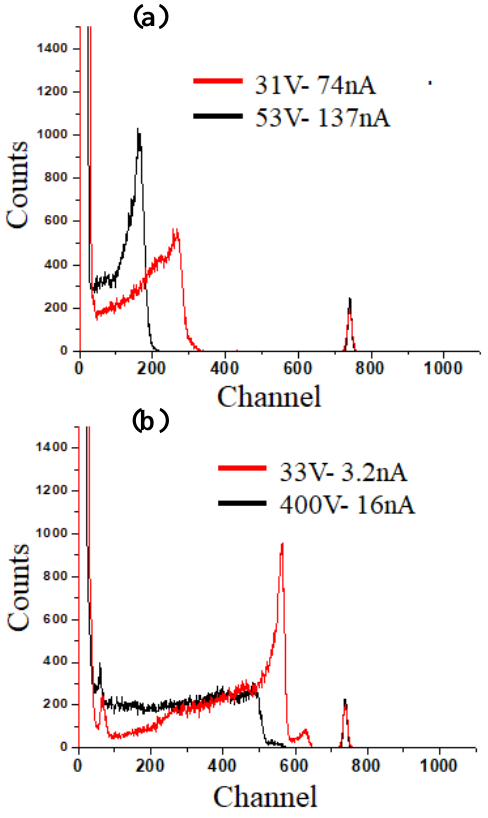
Figure 15. Bias dependence of 57 Co photopeak, measured by; ( a ) CdTe:Cl (1.9 mm) and ( b ) CZT:In (1.4 mm) detector with 7.5% Te-excess growths.